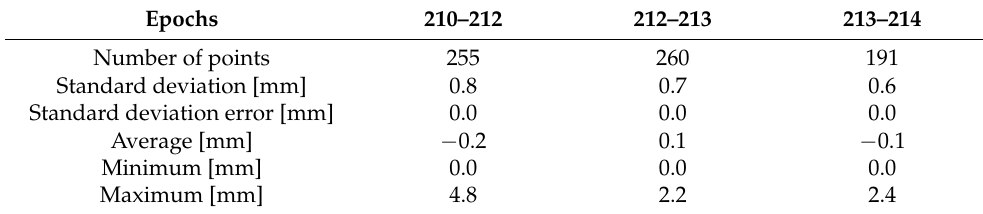
Table 5. Statistical parameters for residuals for BEAM 1.